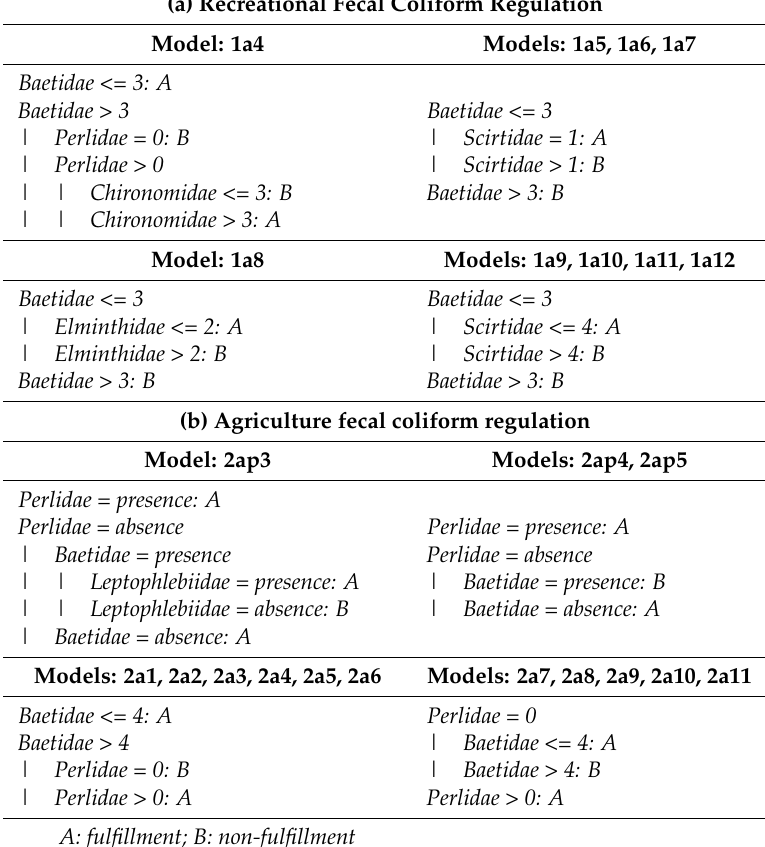
Table A4. Representation of the decision tree models (DTMs) in relation to Water Use Standard fulfillment. (a) Recreational regulation: primary contact (b) Agriculture regulation: agriculture and livestock